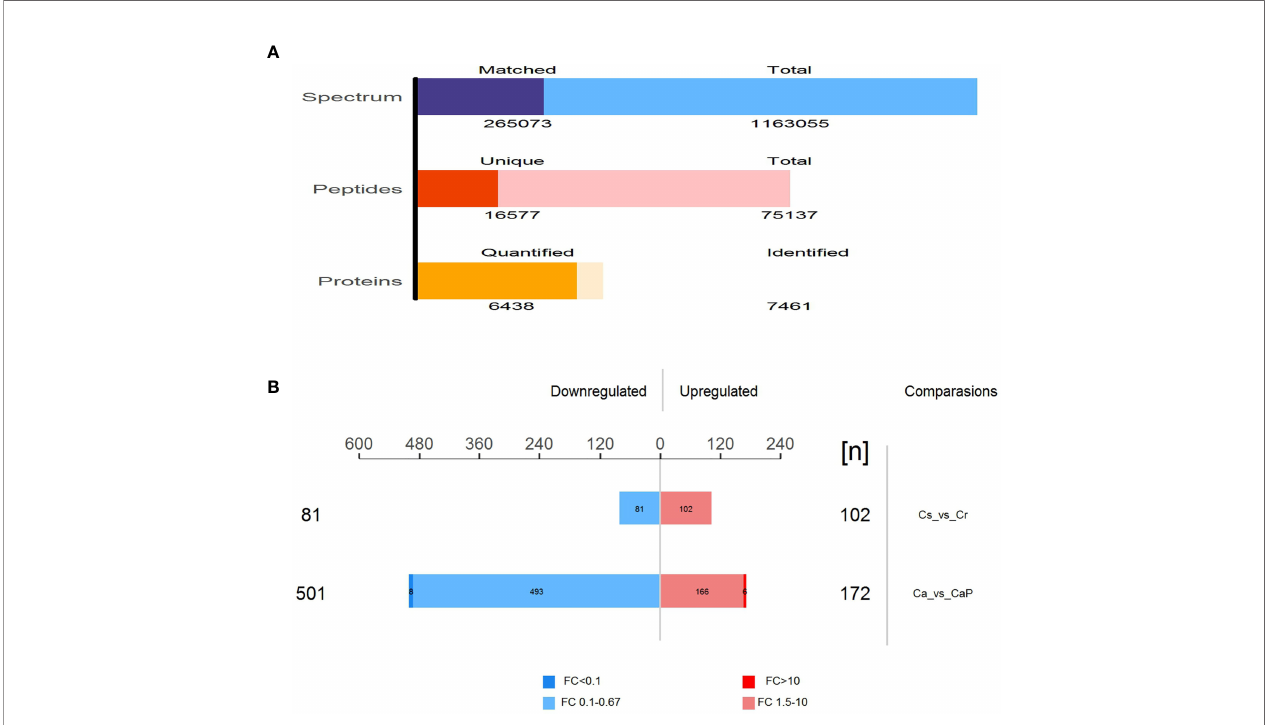
FIGURE 1 | Total number of peptides and proteins identi fi ed by DIA database. (A) Total number ofdifferentiallyexpressed proteins in Ca_vs_CaP and Cs_vs_Cr groups. Quantitative values of proteins inthe samples for subsequent statistical and bioinformatics analysis, including 6,438 proteins and 16,577 peptides. (B) Among the Ca_vs_CaP group, we screened673 differentiallyexpressed proteins (172 upregulatedand501 downregulated). A total of 183 differentiallyexpressed proteins were screened in the Cs_vs_Cr group (102 upregulated and 81